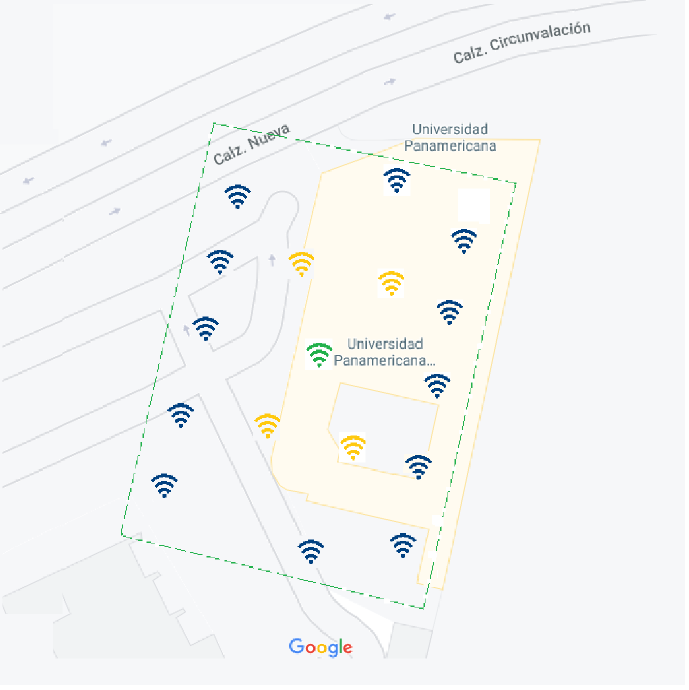
Figure 5. WSN location on campus within an area of 500 m 2